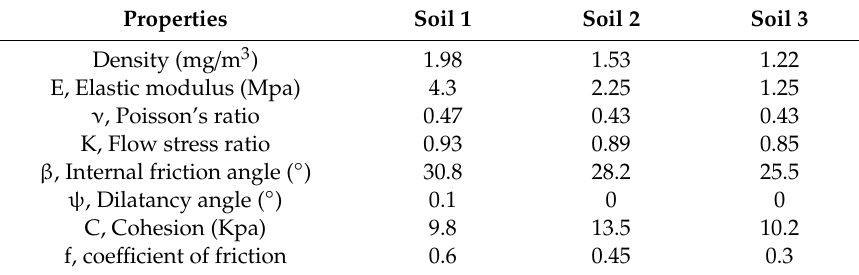
Table 3. Soil properties of soils used in FEM